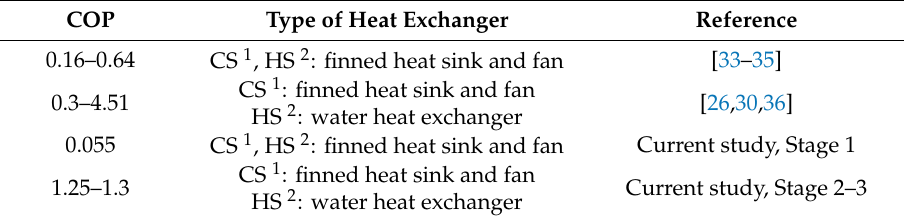
Table 10. Comparison of literature values of COP for selected thermoelectric